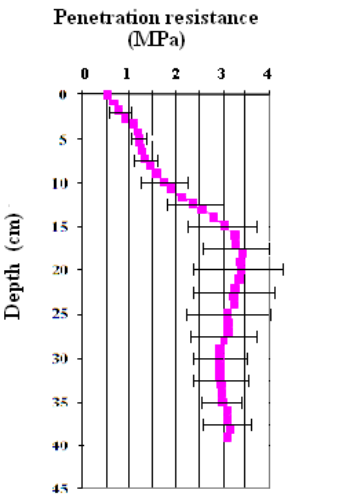
Fig. 4. Soil compaction at Enerata. Rise in penetration resistance Figure 4. Soil compaction at Enerata. Rise in penetration resistance starts at 10 cm, starts at 10cm, which is the average depth of operation of the Mare- which is the average depth of operation of the Maresha plow. The resistance peaks at sha plow. The resistance peaks at 20cm depth. Each point is the 20 cm depth. Each point is the average of ten readings, Figure 5. Typical p rofiles of soil before and after the application of conservation Fig. 5. Typical profiles of soil before and after the application of average of ten readings. tillage (CT). The rugged profile of the undisturbed soil beneath the plowed layer creates fill and spill type of subsurface flow. In contrast, traditional cross plowing conservation tillage (CT). The rugged profile of the undisturbed results in sharp horizontal profile of furrow bottoms that are laid along the slope, at soil beneath the plowed layer creates fill and spill type of subsur- about 10 cm depth, thus leading to increased flow momentum and soil erosion. face flow. In contrast, traditional cross plowing results in sharp hor- izontal profile of furrow bottoms that are laid along the slope, at about 10cm depth, thus leading to increased flow momentum and soil